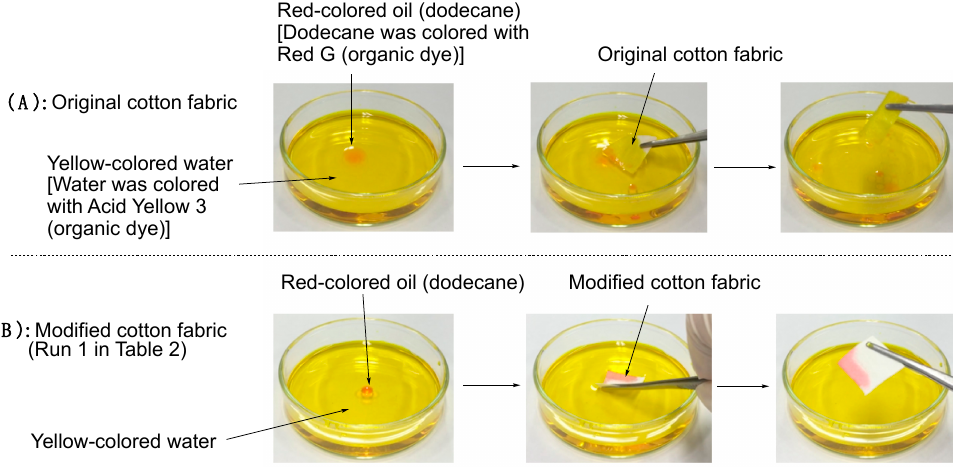
Figure 8. Adsorption of red-colored oil (dodecane) droplets spread on yellow-colored water interface using pristine cotton fabric ( A ) and the modified cotton swatch with R F -VMSiO 2 / TAZ nanocomposites (Run 1 in Table 2) ( B ).